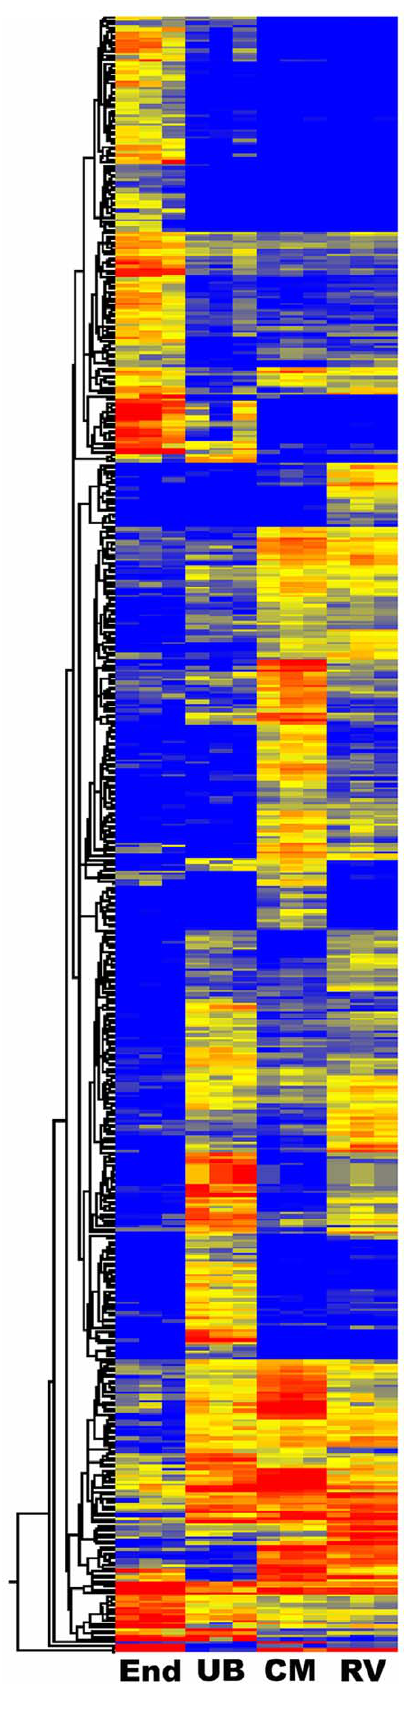
Figure 2. Heat Map displaying gene expression differences (531 probe sets) between different kidney development compartments. Shown are End (E15.5 endothelial cells), UB (E11.5 ureteric bud), CM (P0 capping mesenchyme), and RV (P4 renal